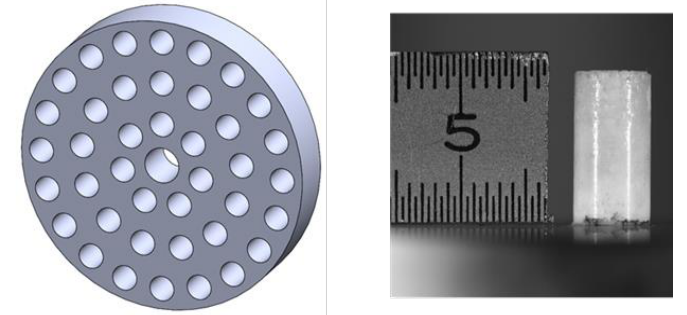
Figure 1. Mold to produce samples and the sample of bone cement prepared using a